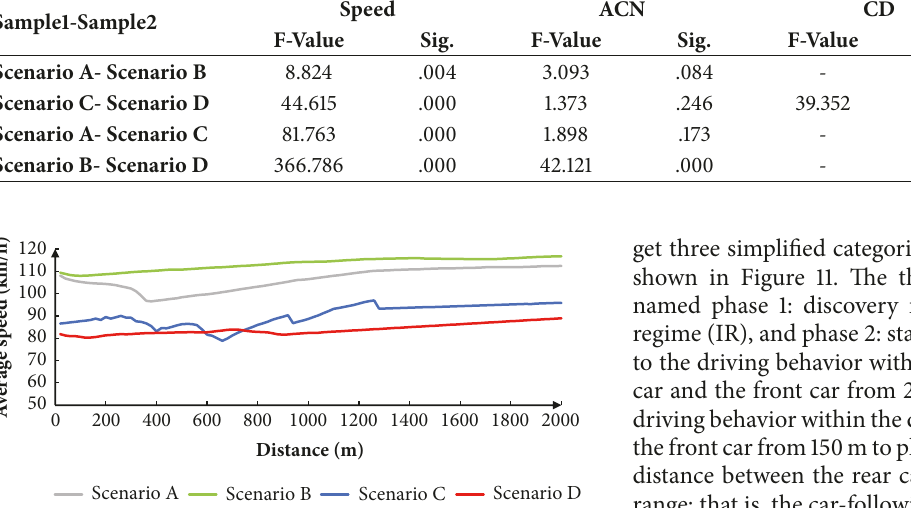
and safety of male drivers have been improved with the initial OBU, which indicate that male drivers are more suitable to use